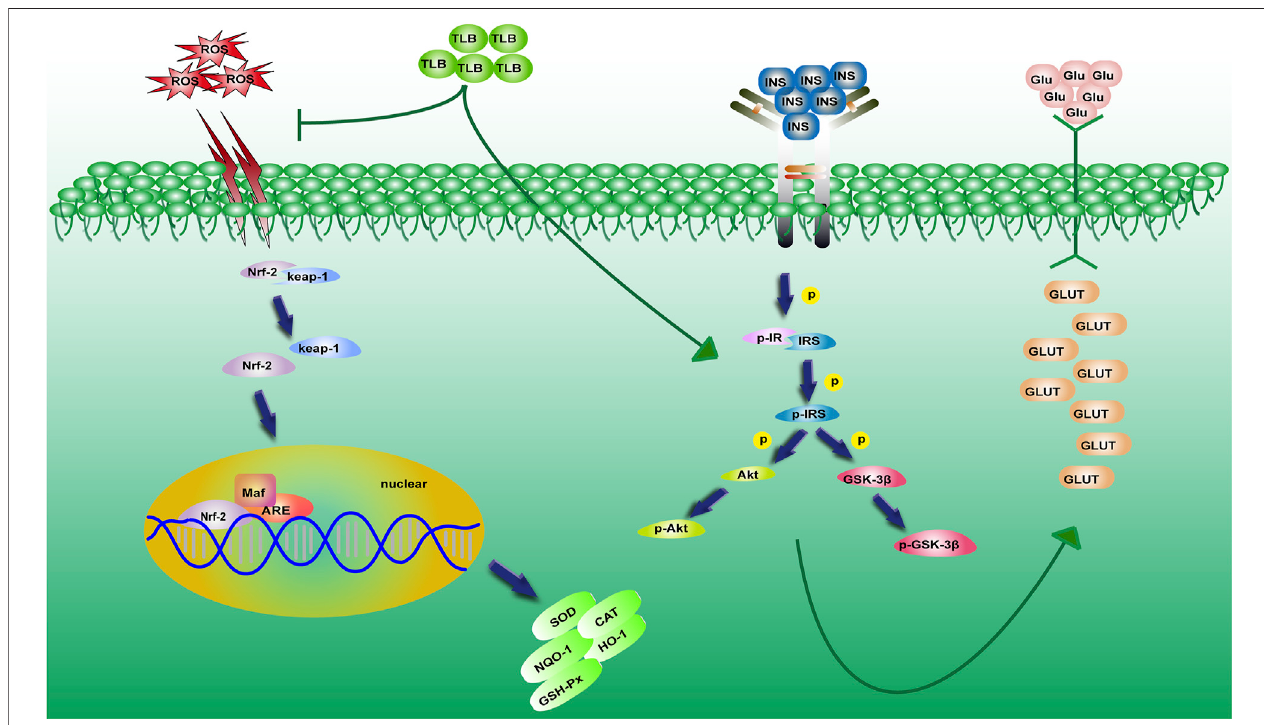
FIGURE 9 | A schematic showing the underlying mechanisms of the anti-T2DM effect of TLB in KK-Ay mice. TLB relieved oxidative stress by activating the Nrf2/ ARE signaling pathway and mitigated insulin resistance by regulating the insulin signaling transduction pathway in KK-Ay mice.